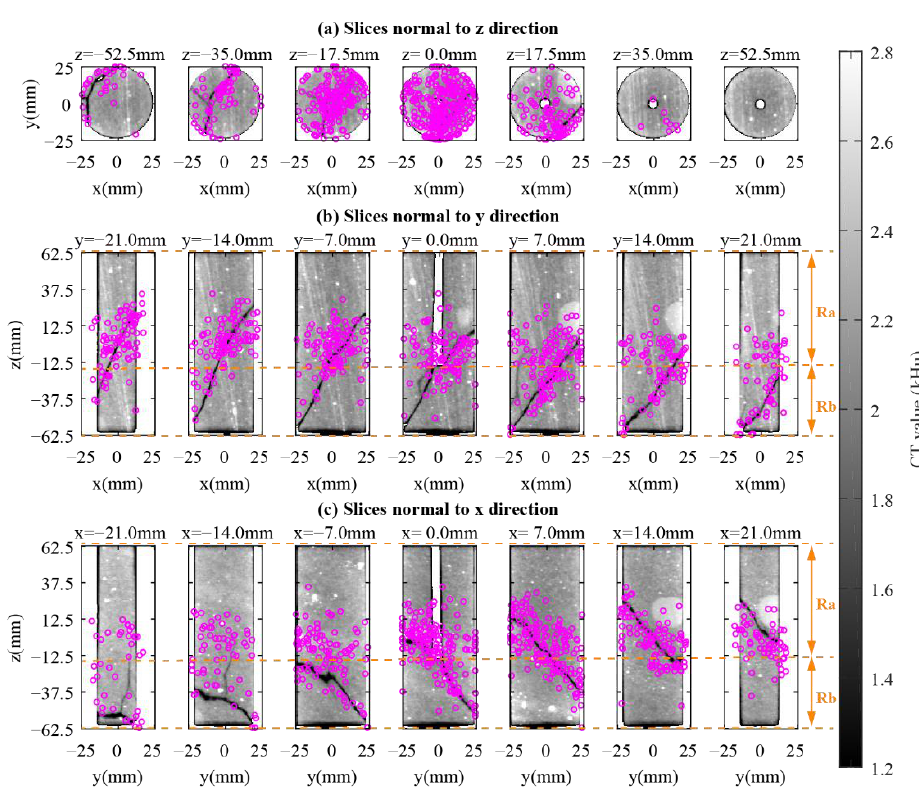
Figure 8. Comparison between the location of acoustic emission events (magenta circle) in the H2 phase and CT scan images after rock fracture. The orange dotted line represents the boundary between region Ra and Rb.